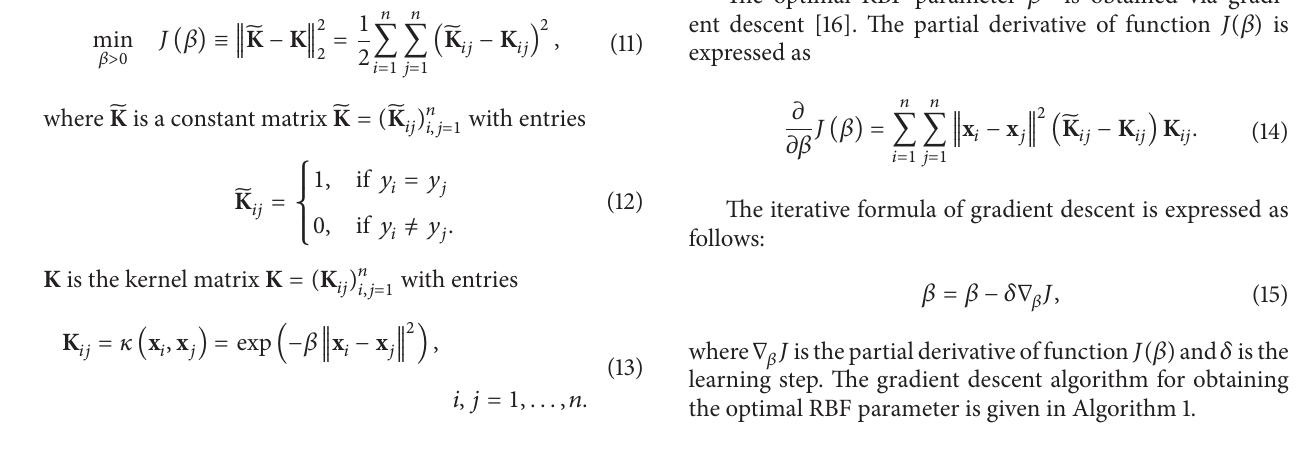
The schematic illustration of function 𝐽(𝛽) is shown in Figure 1. The horizontal axis represents the RBF parameter 𝛽 and the vertical axis represents the corresponding 𝐽(𝛽) . The graph shows that there is only one minimum value which is the optimal RBF parameter value in the proposed